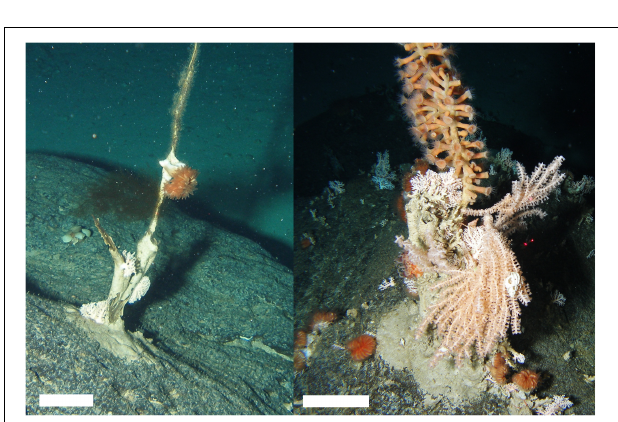
FIGURE 8 | Large stumps attached to the tops of boulders constituted the majority of “soft coral” observations on the summit plateau (cf Primnoidae). Scale bars, 10